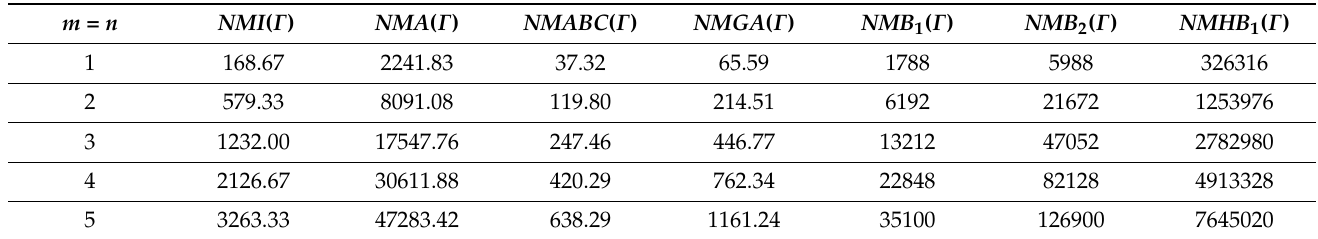
Table 9. Comparison Table for Theorem